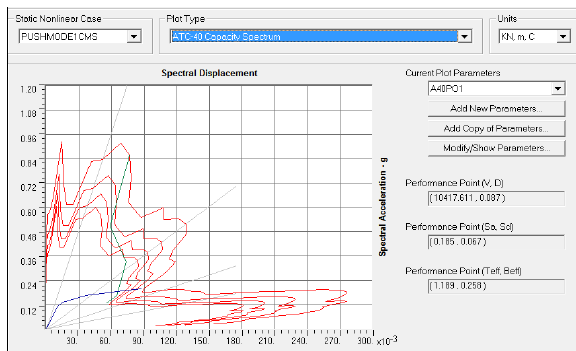
Fig. 15. Capacity spectrum in the transverse direction for Kobe earthquake